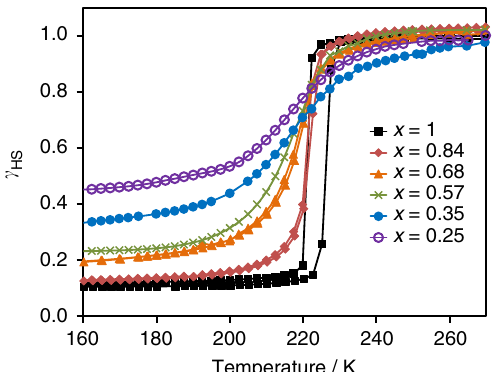
Fig. 3 Effect of metal dilution on spin crossover. The Fe(II) high spin fraction ( γ HS ) was calculated from variable temperature magnetic susceptibility data for [Fe x Ni 1 − x ]. Lines are included for